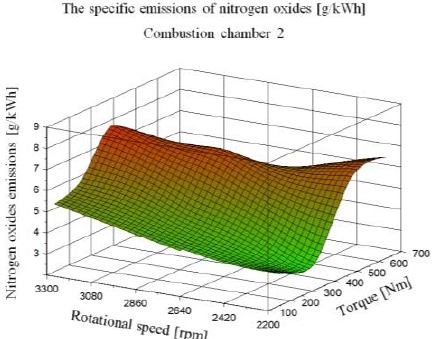
Figure 24. The nitrogen oxides emission of the engine equipped with the combustion chamber 2.